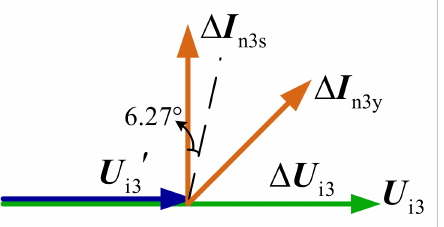
Figure 4. Phasor diagram of the third-harmonic current